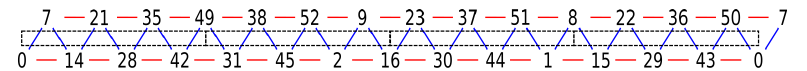
Figure 8: Transitions for key bits in C register. Coloring depicts occurrence frequency. The dashed boxes mark the XORs used to build unique labels for the four